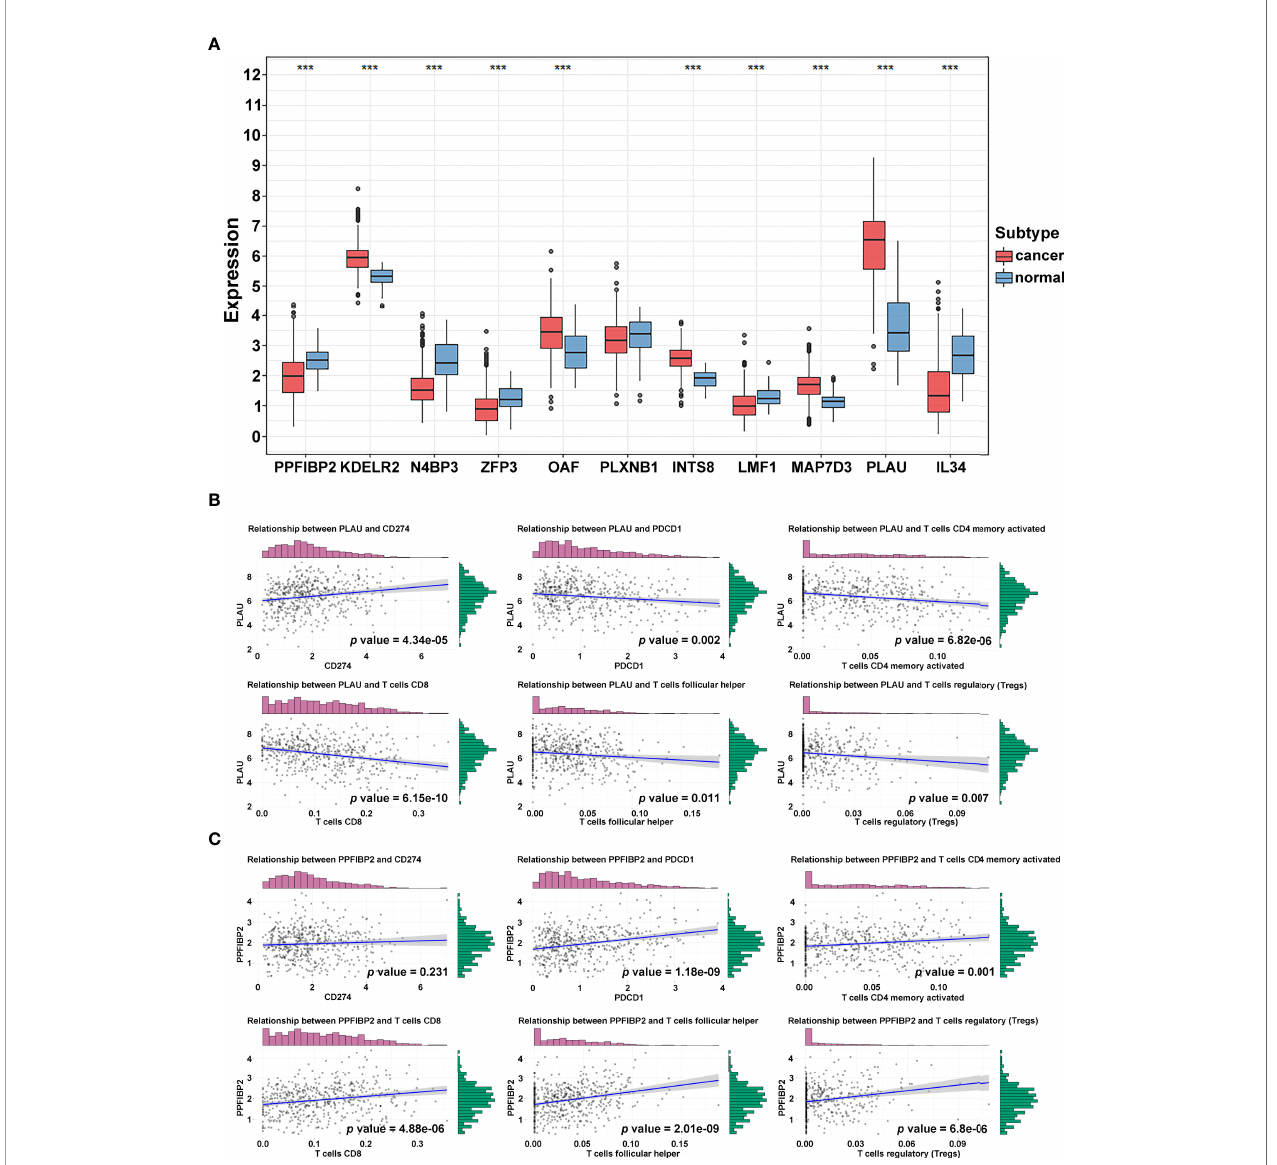
FIGURE 7 | Immune-related hub gene identi fi cation. (A) Differential expression of crucial genes in cancer and normal tissue (*** p < 0.001; ** p < 0.01; * p < 0.05). (B, C) Correlation of PLAU (B) and PPFIBP2 (C) and immune